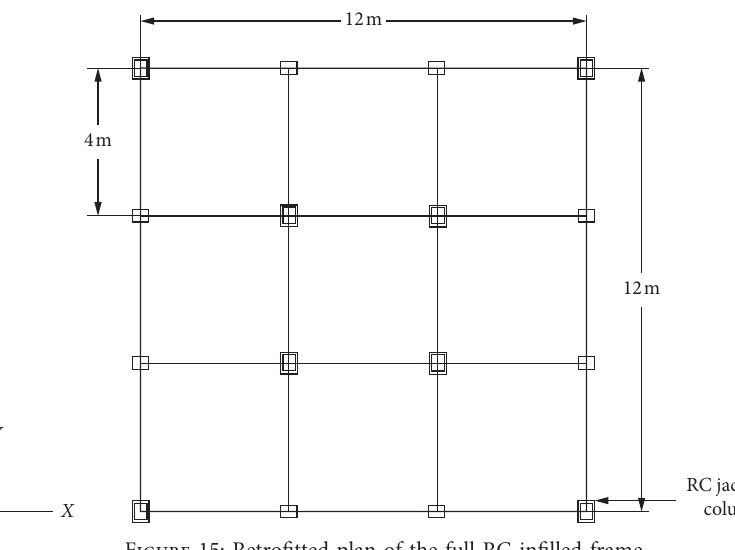
Figure 15: Retrofitted plan of the full RC-infilled frame.